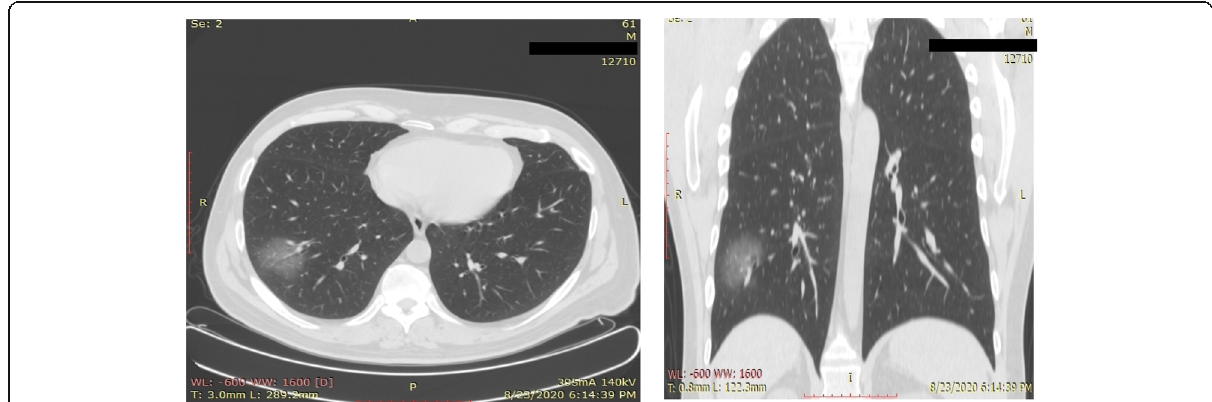
Fig. 1 Thirty-two-year-old female patient presented with sore throat and mild fever. Her PCR test was negative, and the CT revealed unifocal ground glass opacity peripherally located in the right lower lobe. Lung involvement was less than 5%, i.e., CT severity score is 1